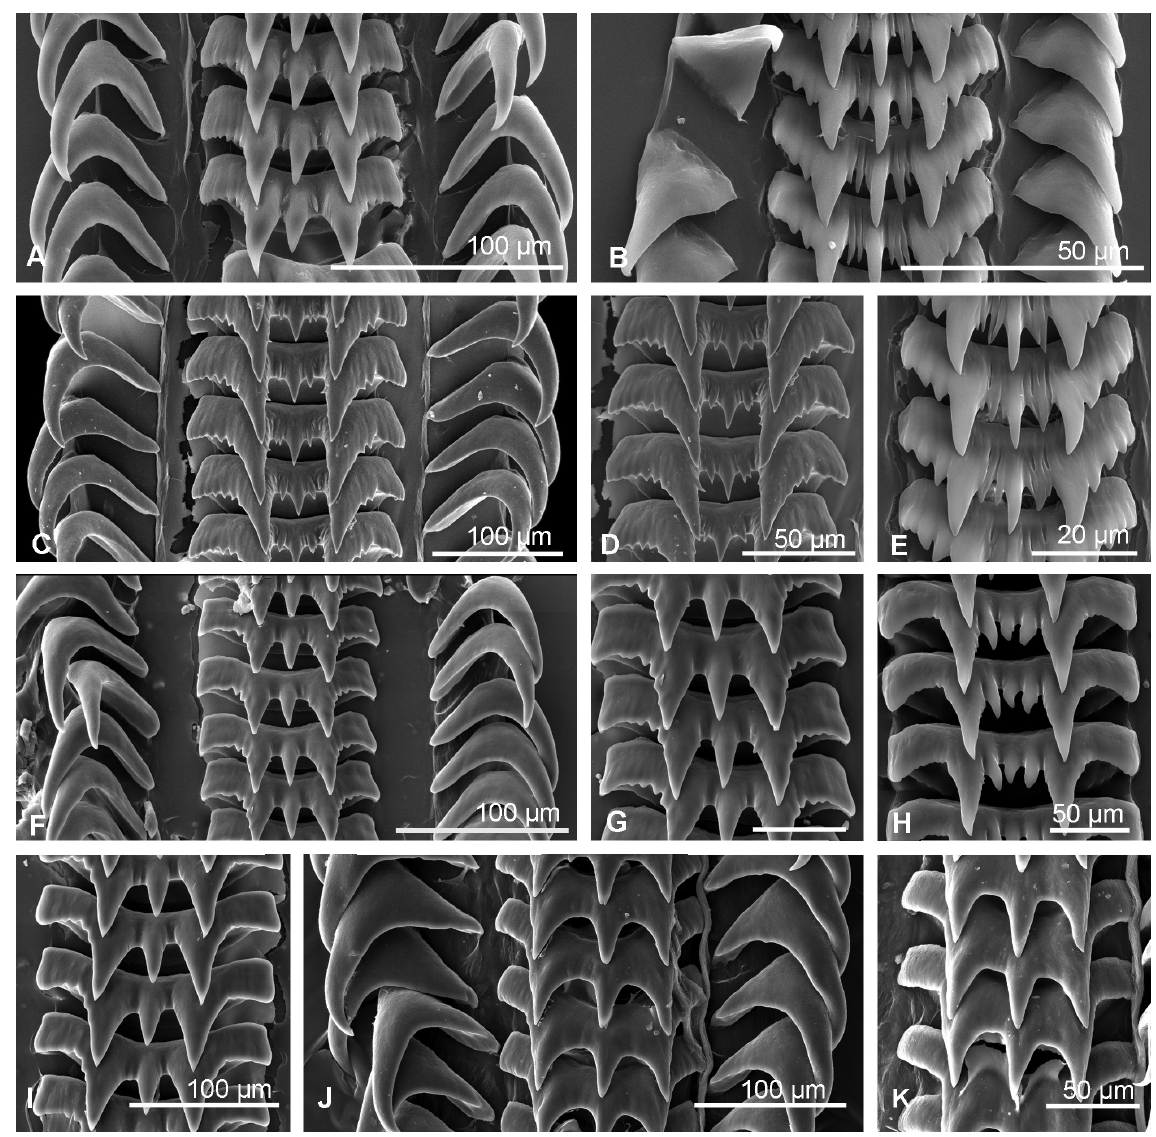
Fig. 20. Radulae of species of Amalda H. Adams & A. Adams, 1853. A . Amalda sp., MNHN IM-2013- 63891 (shell on Fig. 19A–B). B, E . A. monilifera (Reeve, 1864), MNHN IM-2013-63898 (shell on Fig. 19F–G). C–D . A. contusa , MNHN IM-2009-22264, SL 22.7 mm. F–I . A. hayashii Ninomiya, 1988. F–G . MNHN IM-2013-44413 (shell on Fig. 19J–K). H . MNHN IM-2013-44432. I . MNHN IM-2013- 44457, SL 38.2 mm. J–K . A. hinomotoensis (Yokoyama, 1922), MNHN IM-2019-619, SL